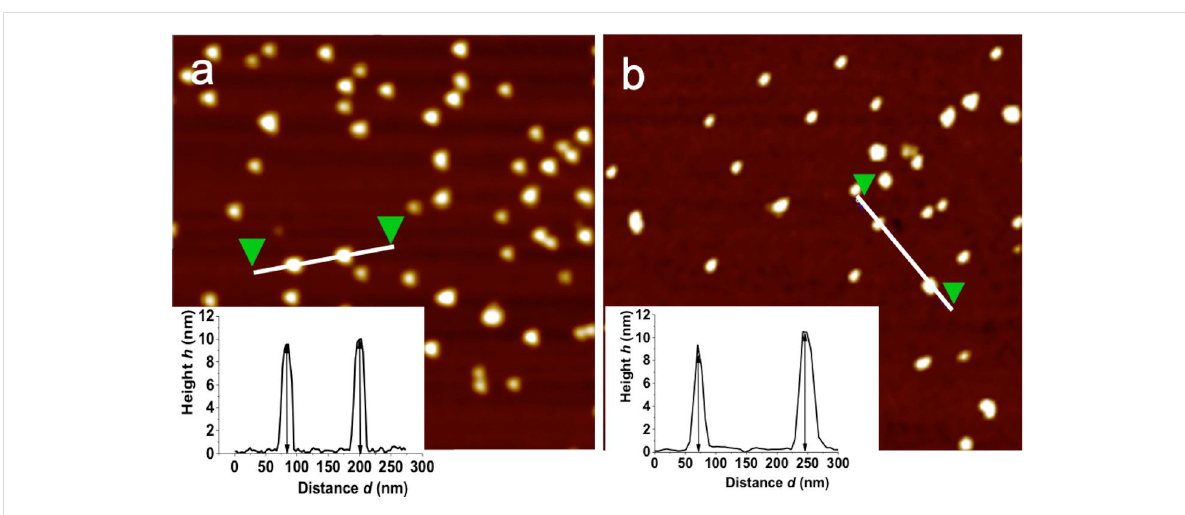
Figure 9: AFM topography images (1 × 1 µm) and height profiles of a) IONP@C 2 F 5 OEG 8 Den and b) IONP@C 2 H 5 OEG 8 Den. Dispersions of IONPs in ethanol (0.002 mg mL − 1 ) were spin-coated on silicon wafers.